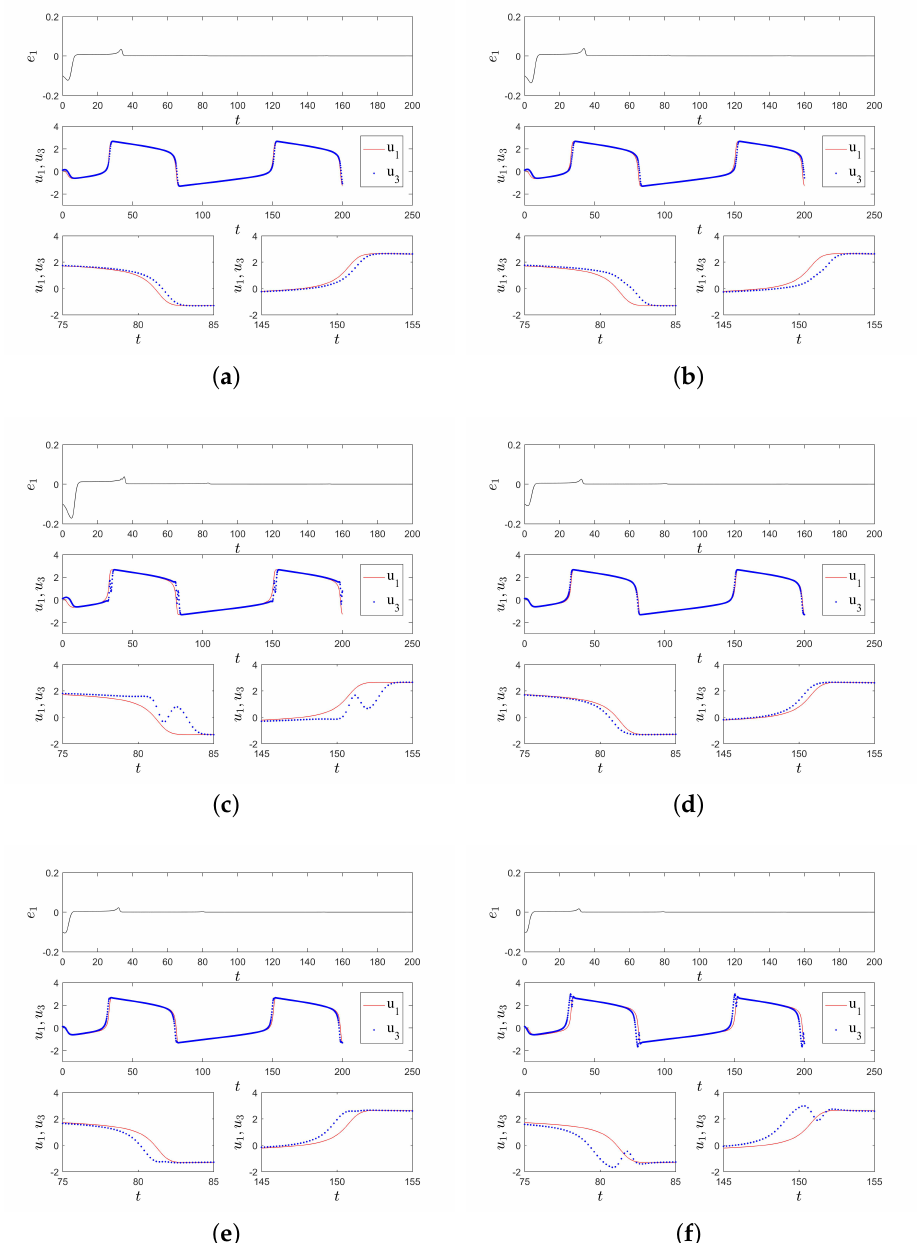
Figure 2. Synchronization errors and functional relation between u 1 and u 3 in System (3) with H ( u 1 ) = G ( u 1 , u 2 , τ ) , k = − 0.7 and ( a ) τ = 0.5, ( b ) τ = 1, ( c ) τ = 2, ( d ) τ = − 0.5, ( e ) τ = − 1, and ( f ) τ = −